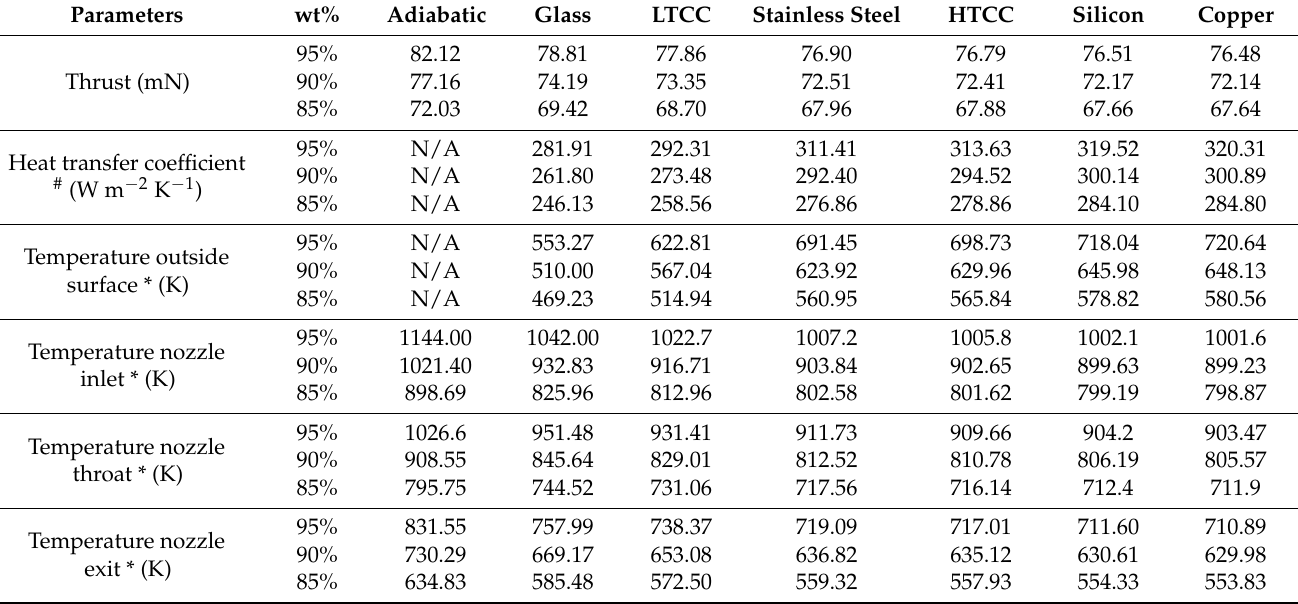
Table 5. Summary of the simulation results in regard to the different materials and propellant weight